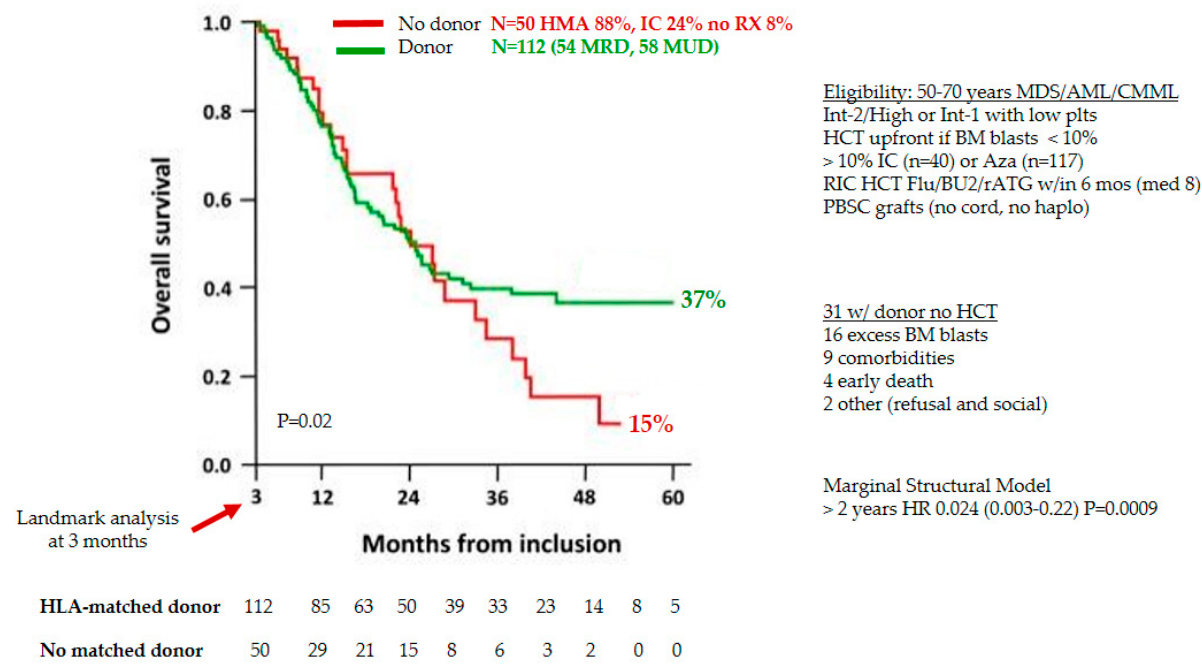
Figure 1. Overall survival in higher risk MDS patients with or without a donor. This is a prospective French study showing an advantage of survival in patients with a donor (Leukemia 2015. Robin et